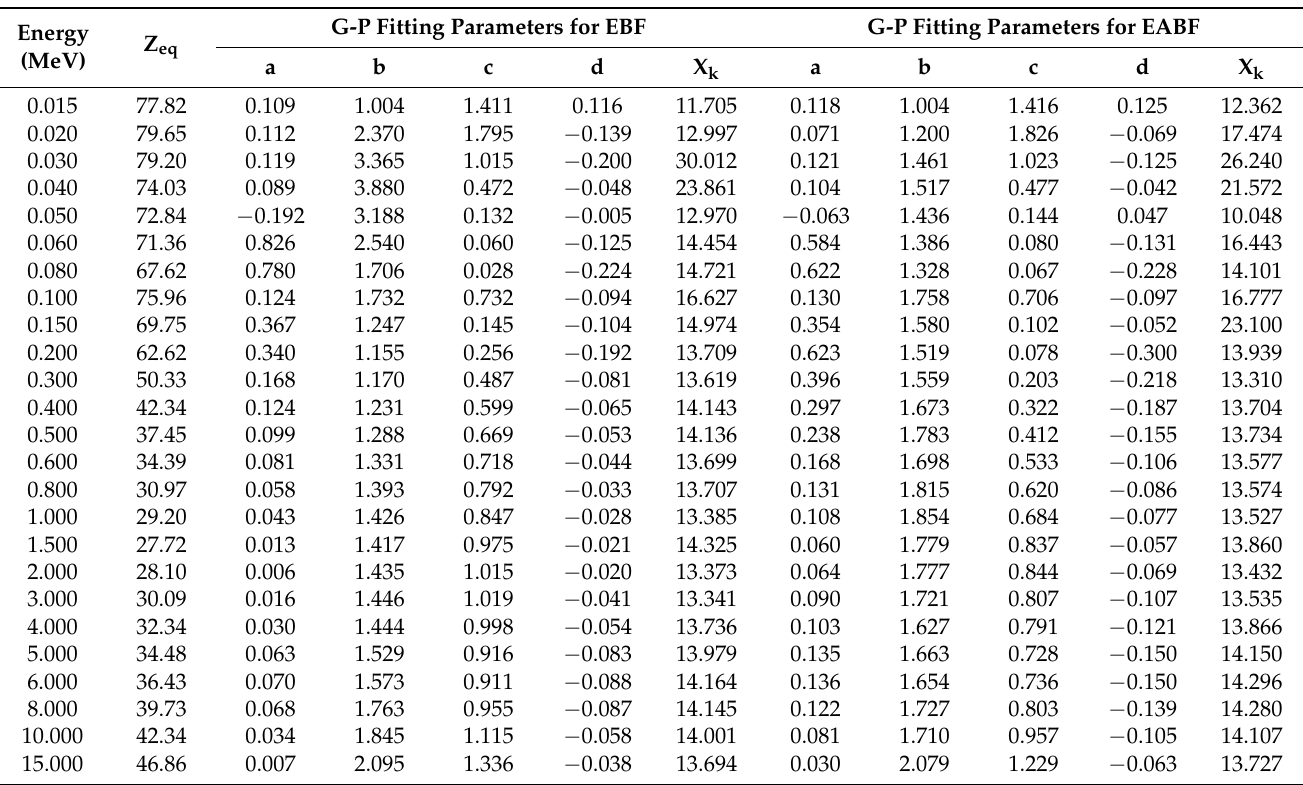
Table 7. (EBF and EABF) G–P fitting coefficients (b, c, a, Xk and d) of LBi50B glass sample.